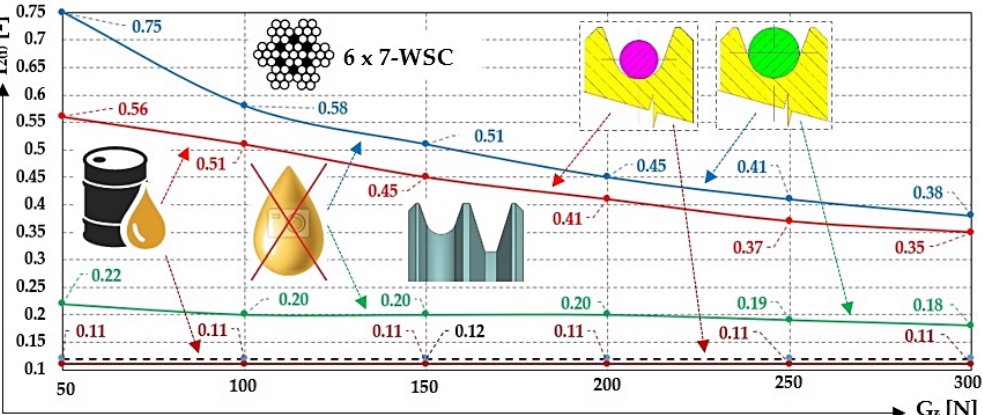
Figure 9. Values measured for the friction coefficient f 2(i) [- ] for a semi-circular groove under a different state of the sheave groove contamination.